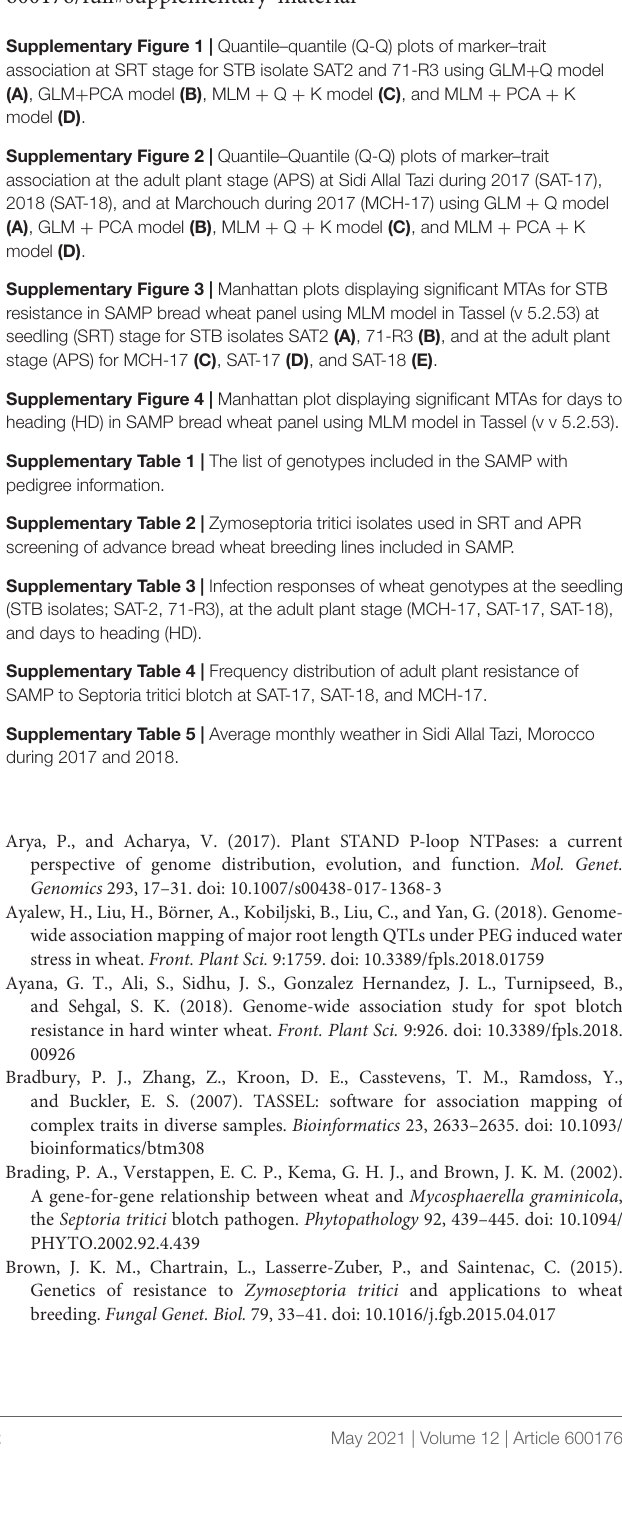
Supplementary Figure 1 | Quantile–quantile (Q-Q) plots of marker–trait association at SRT stage for STB isolate SAT2 and 71-R3 using GLM + Q model